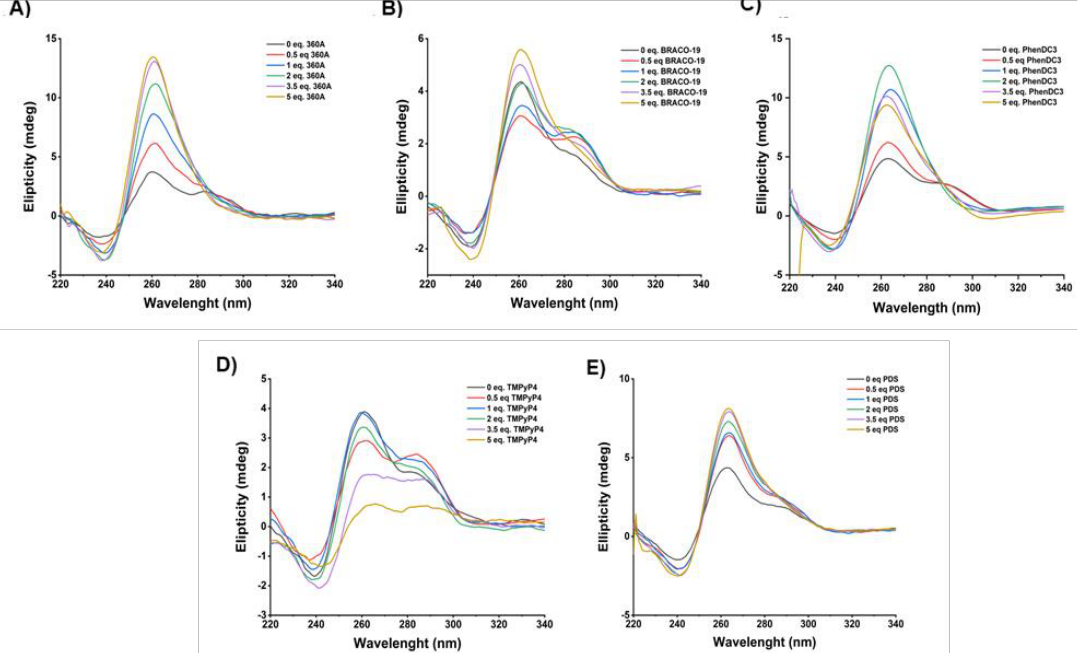
Figure 3. CD spectra of AT11-L2 in the absence and presence of increased molar equivalents of ligands ( A ) 360 A, ( B ) BRACO-19, ( C ) PhenDC3, ( D ) TMPyP4 and ( E ) PDS. CD spectra were acquired in a buffer containing 10 mM of lithium cacodylate and 100 mM of KCl. Table 1. Thermal stabilization induced by ligands in the AT11-L2 sequence measured by CD melt- ing experiments.